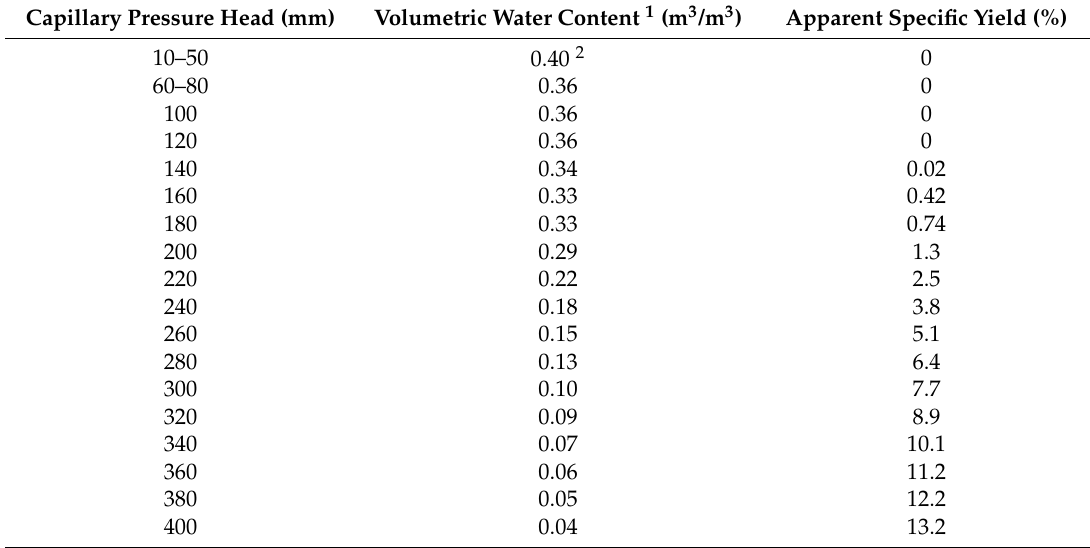
Table 2. Summary of water-retention and drainable porosity measurements for Monterey #30 fine